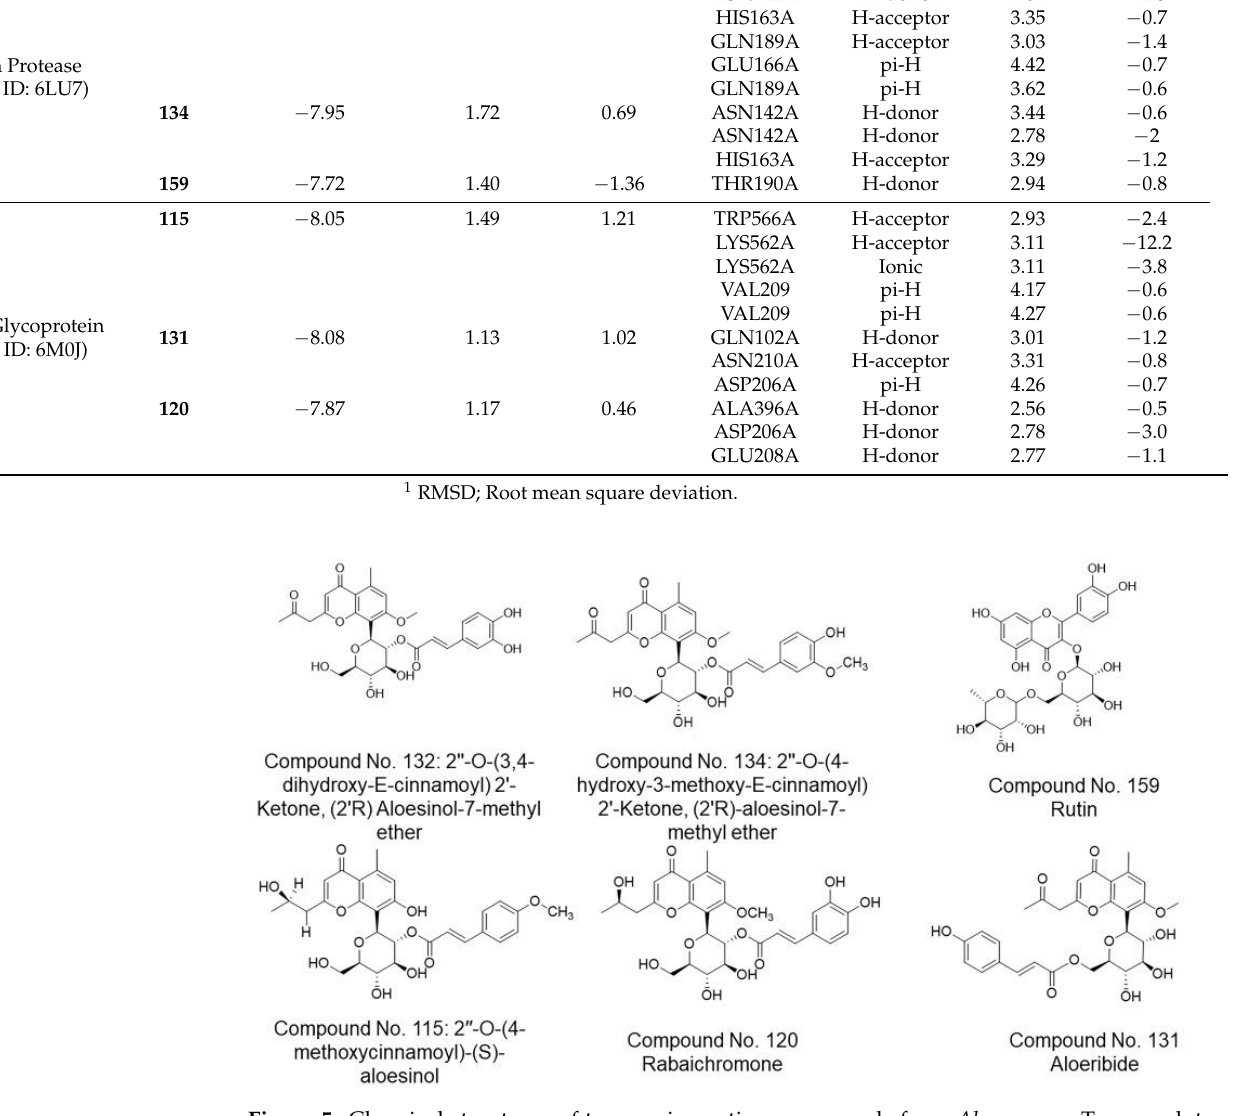
Figure 5. Chemical structures of top scoring active compounds from Aloe genus. Top panel, top scoring active compounds for SARS-CoV-2 protein M pro . Lower panel, top scoring active compounds for SARS-CoV-2 protein spike glycoprotein.